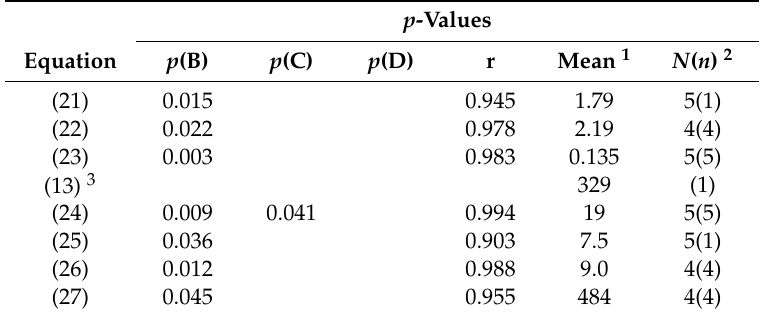
Table 5. Statistics of linear equations for the prediction of aqua-regia-extractable contents of trace metals (X(pred)) from the readings (soil and mining methods) obtained using pXRF on the organic